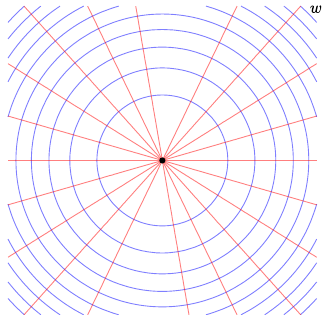
Figure 1 . The (cid:12)gure shows a foliation of the plane describing the half-line modular (cid:13)ow. This cor- responds to polar coordinates on the plane, with the angular direction determining the temperature